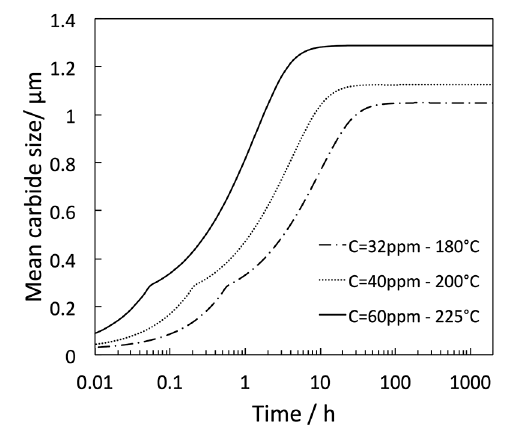
Figure 5. Carbide mean size evolution for samples with 32, 40 and 60ppm aged at 180, 200 and 225°C, respectively.